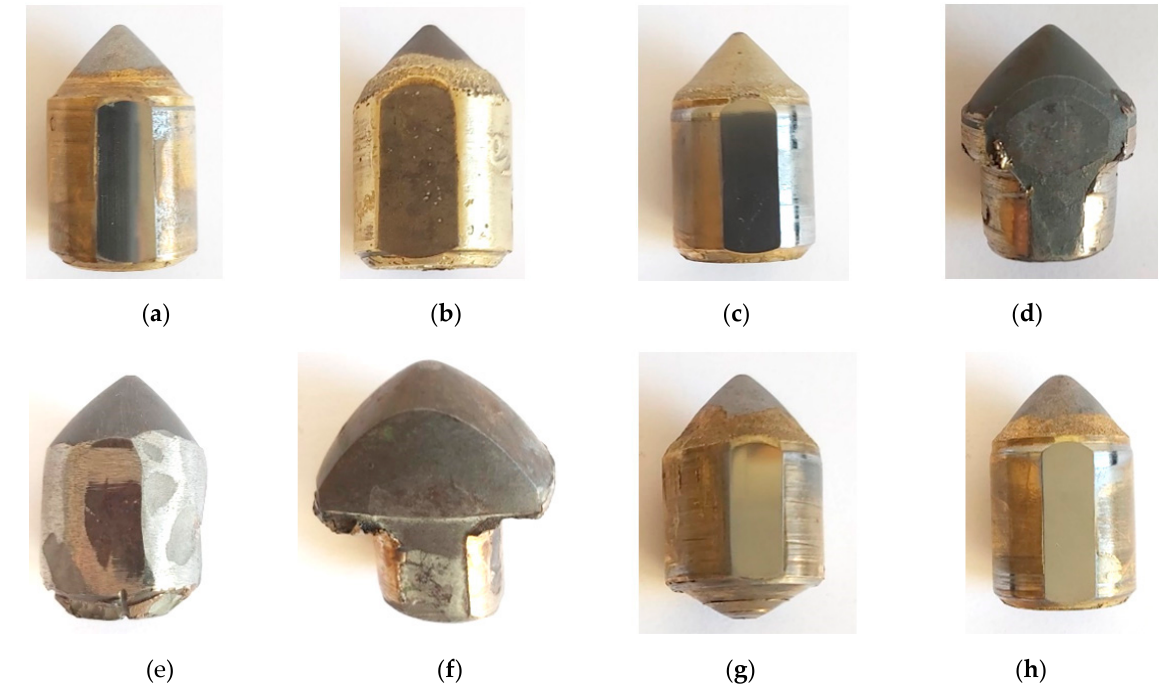
Figure 12. Tips in the form of WC-Co inserts, obtained by extruding from the tested picks: ( a ) pick for roadheaders (Figure